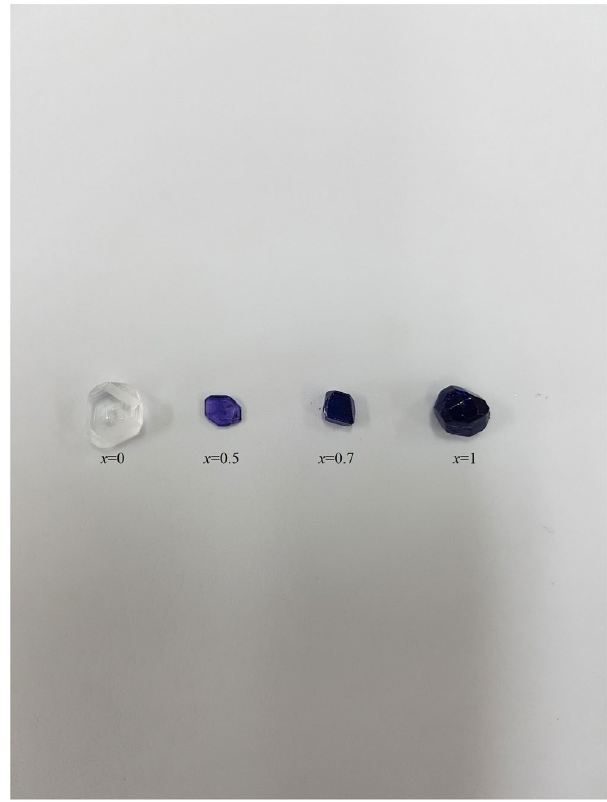
Figure 2. Colors of mixed crystals [N(CH 3 ) 4 ] 2 Zn 1- x Cu x Br 4 ( x = 0, 0.5, 0.7, and